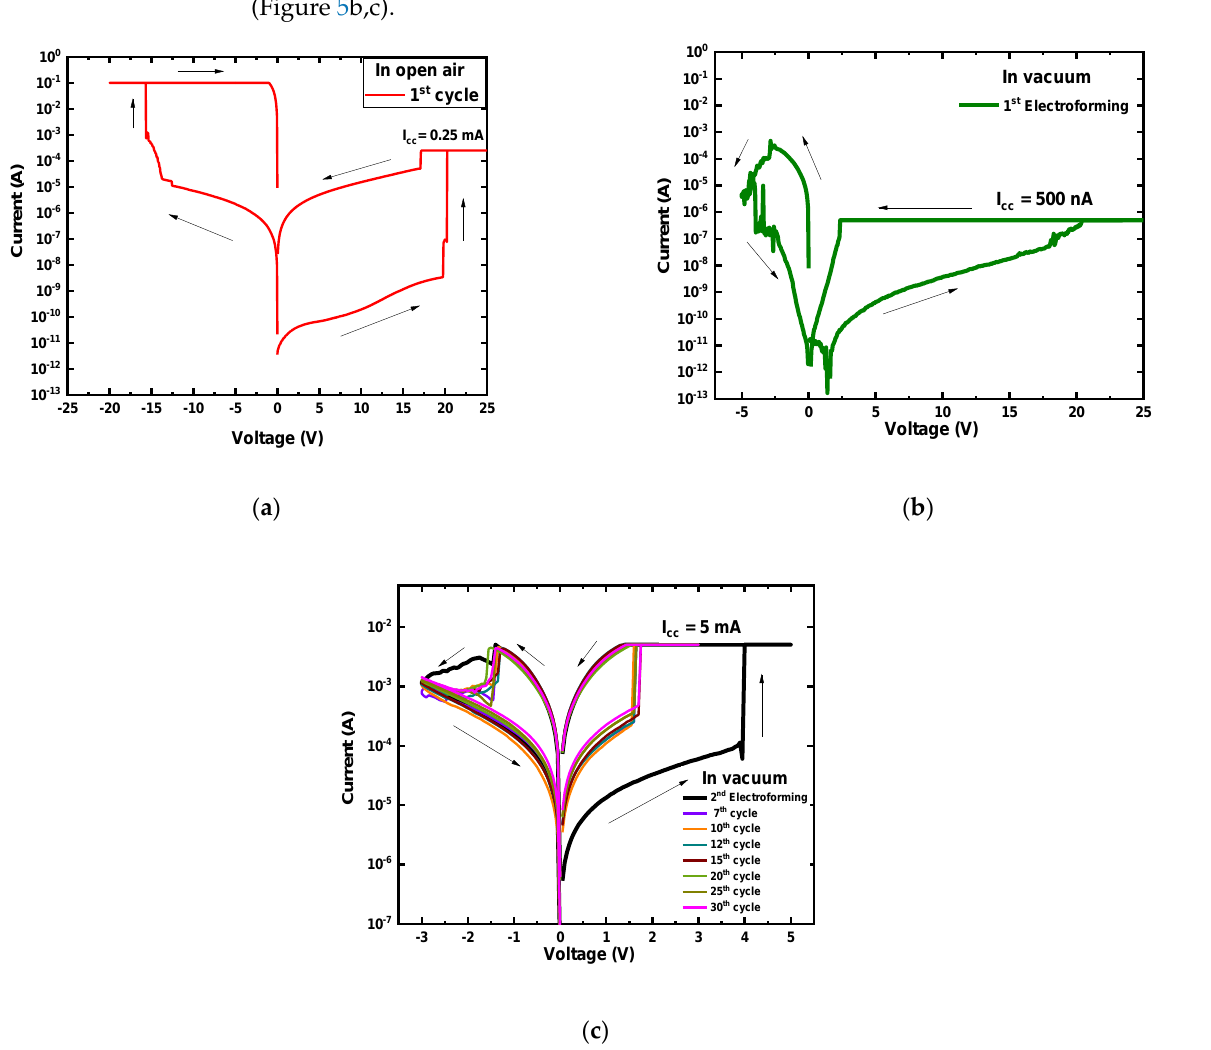
Figure 5. Typical I − V characteristics of post-deposition annealed MgF x − based Ti/MgF x /Pt memory devices. ( a ) in open − air; ( b ) in vacuum first electroforming; ( c ) in vacuum second electroforming with I cc = 5 mA.